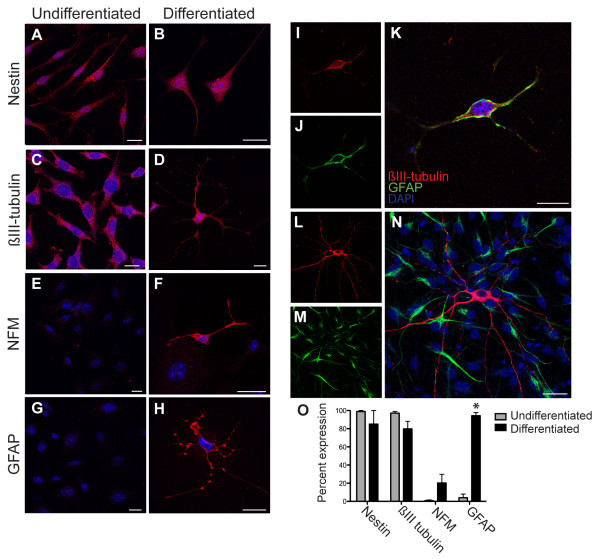
Differentiated mDPSC express neuronal and glial markers. A-H) Representative immunohistochemistry images of undifferentiated mDPSC showing strong expression of nestin and ßIII tubulin but low levels of NFM and GFAP. At day 11 of neuronal differentiation mDPSC retained strong nestin and ßIII tubulin expression (A-D). NFM and GFAP expression was markedly increased following neural induction (E-H). I-K) The majority of cells co-expressed ßIII tubulin and GFAP. L-N) Validation of co-expression result using the same ßIII tubulin and GFAP antibodies applied to murine cortical cells, which demonstrates the expected distinction between neurons and glia. O) Quantification of neural IHC. The relative expression of each neural marker before and after differentiation, counted as percent expression per four representative fields of view at 20x magnification. Scale bar = 25 μm. *P <0.05. GFAP, glial fibrillary acidic protein; IHC, immunohistochemistry; mDPSC, murine dental pulp stem cells; NFM, neurofilament-medium chain.